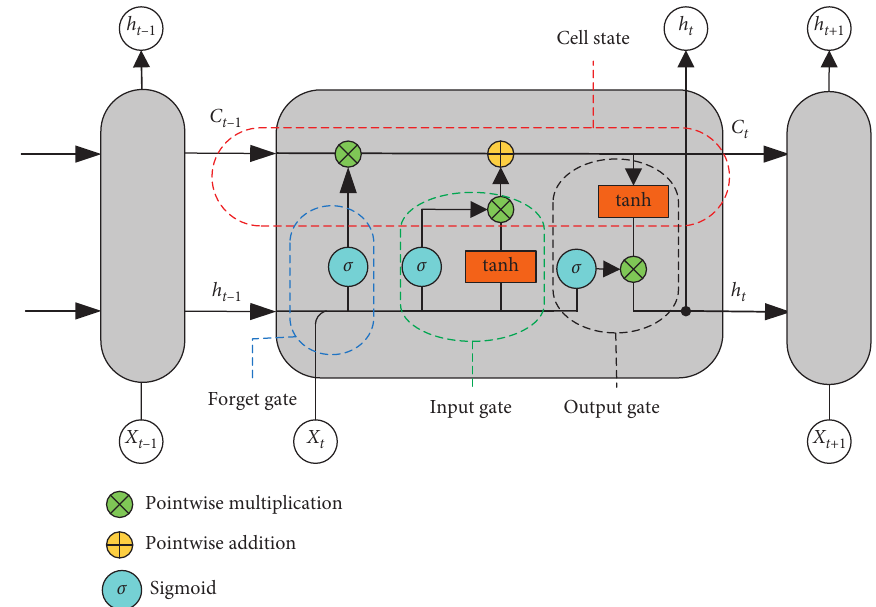
Figure 5: The structure diagram of the LSTM